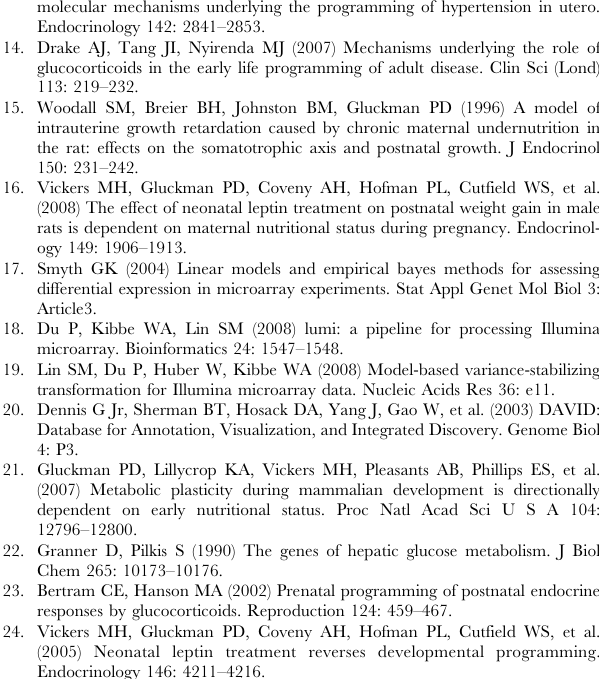
Table S3 Log Fold Change, Adjusted p-value, Accession Number, and Gene Symbol for the 249 differentially expressed genes (p-value , 0.05).